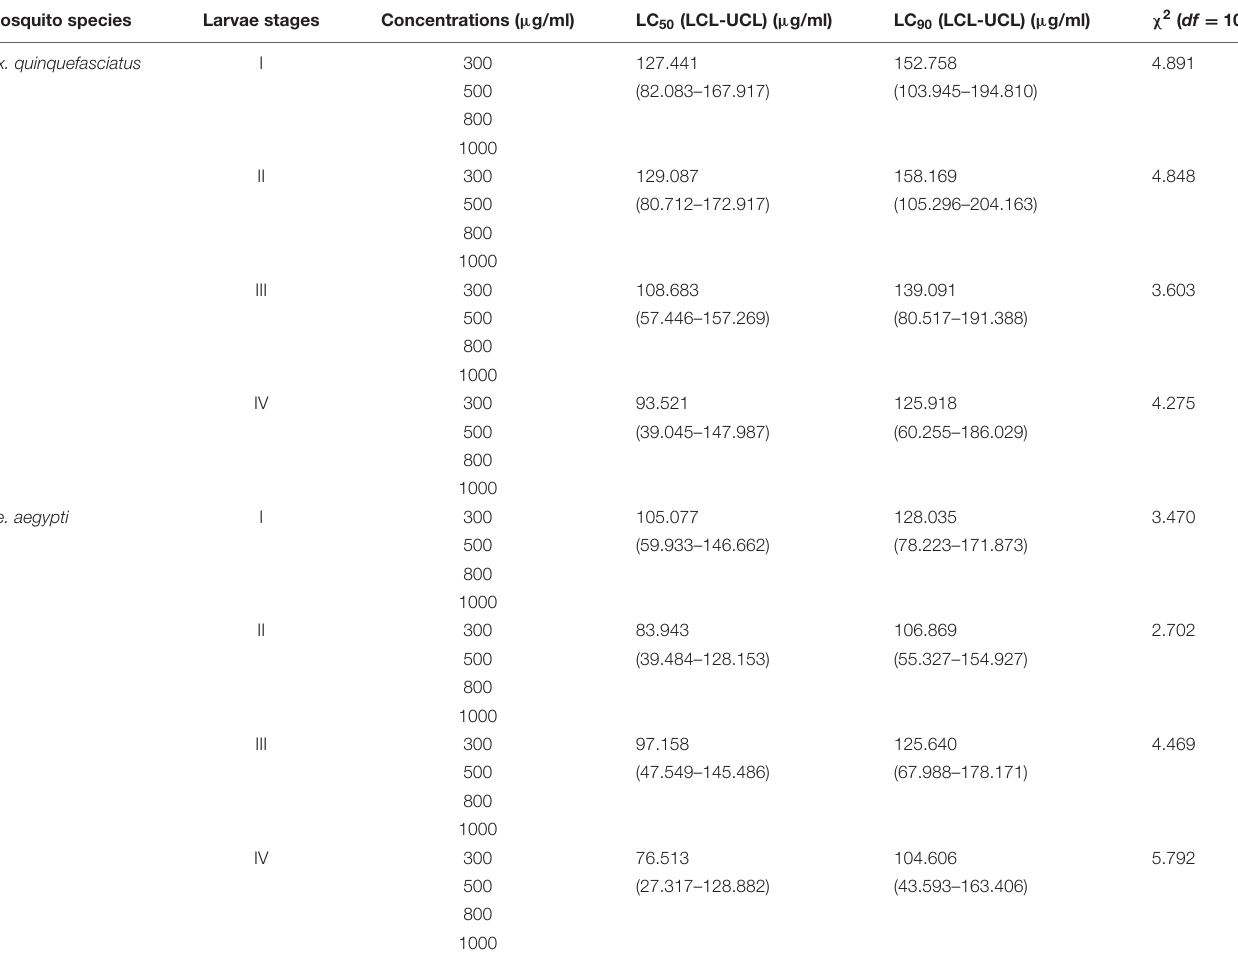
TABLE 1 | Larvicidal activity of Penicillium daleae fungal mycelium (ethyl acetate) extract against Culex quinquefasciatus and Aedes aegypti (after 48 h exposure). Mosquito